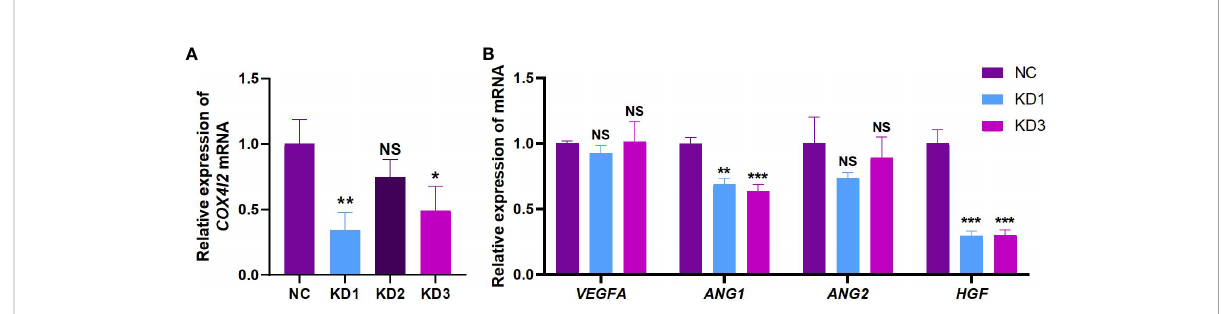
FIGURE 3 The knockdown of COX4I2 in NIH3T3 cell line resulted in changes of angiogenesis-related factors. (A) Changes of COX4I2 mRNA in NIH3T3 cell line after interference of three targets. (B) Changes of angiogenesis-related factors VEGFA, ANG1, ANG2 and HGF mRNA in NIH3T3 cell line after COX4I2 knockdown. (NS: No Signi fi cance; *: P<0.05; **: P<0.01; ***: